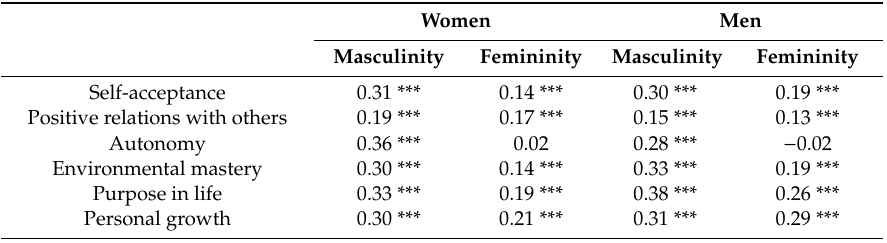
Table 3. Bivariate correlations between masculinity and femininity with well-being scales for the groups of women and